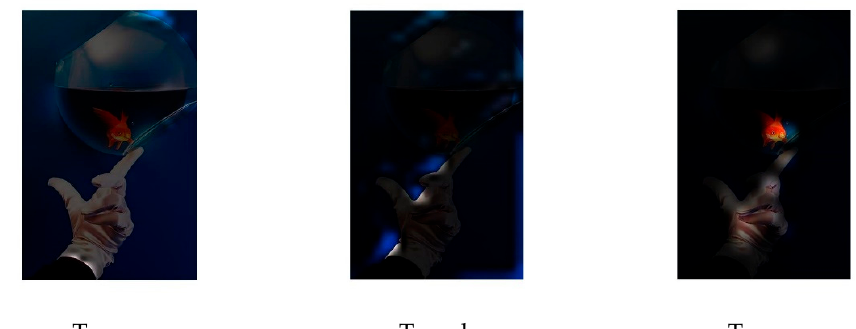
FFP(x, y) regarding the FD-determined optimal model. Figure 10.